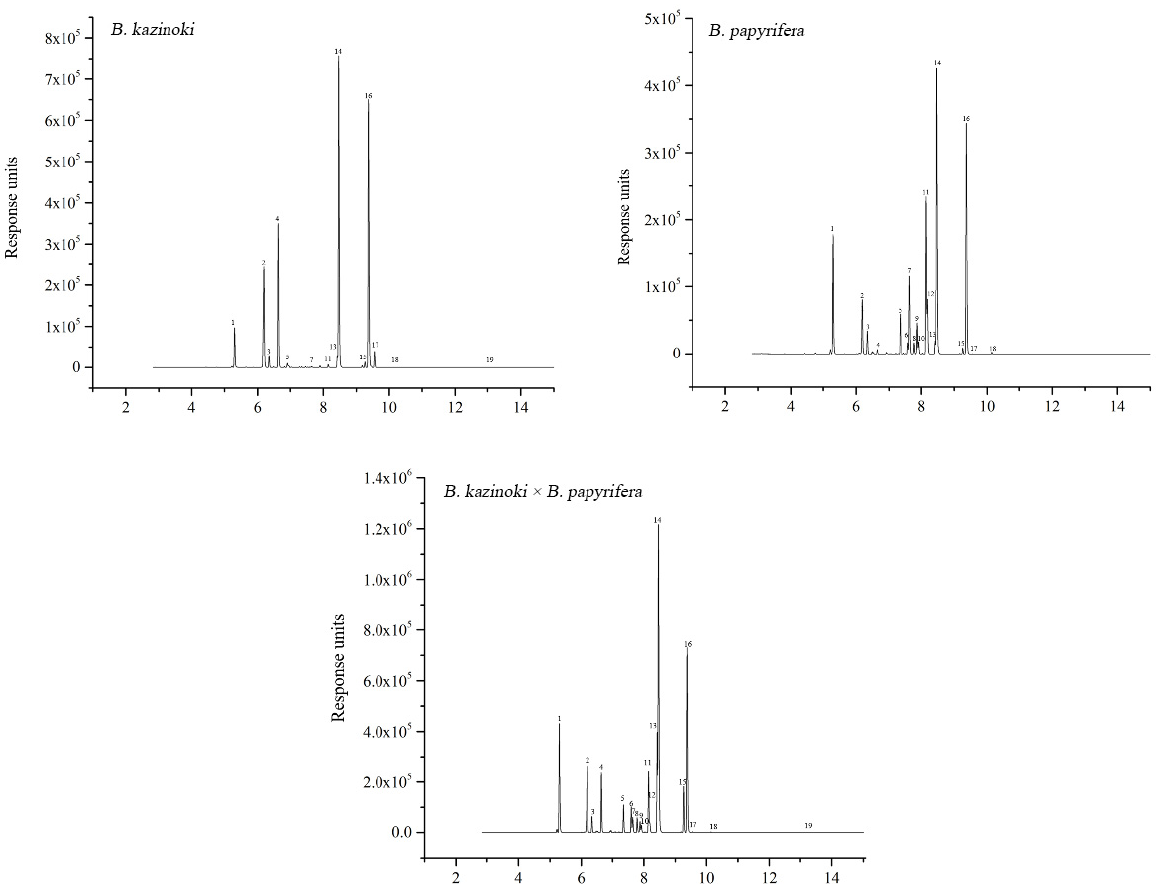
Figure 4. The UPLC elution profile of detected compounds from B. papyrifera , B. kazinoki and B. kazinoki × B. papyrifera leaves. The number of the peaks corresponds to that of the compounds in Table 1.